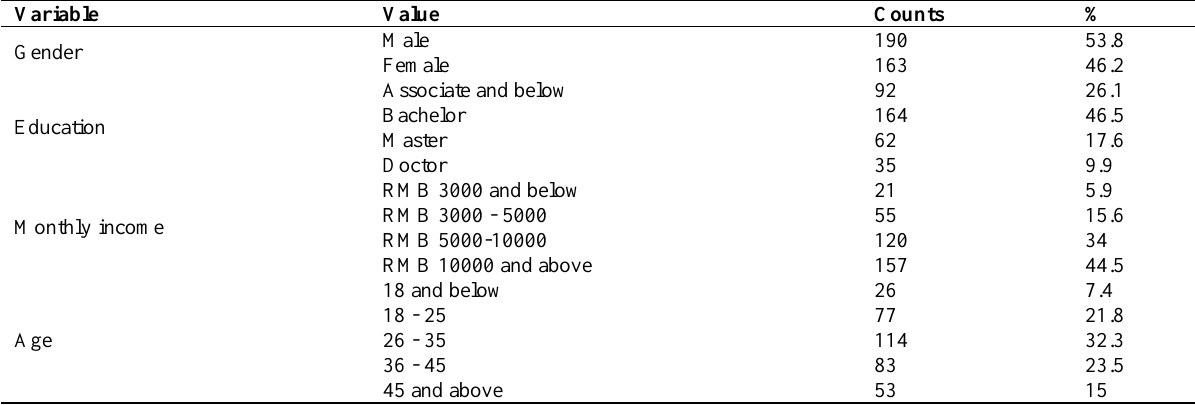
Table 2: Composition of the samples